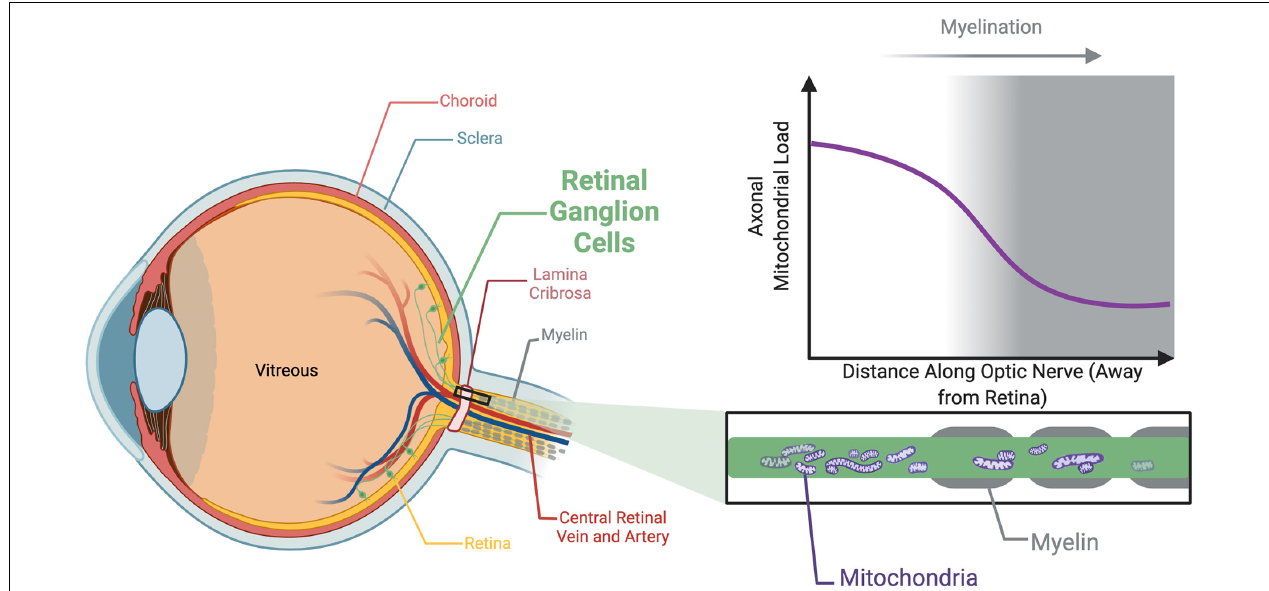
FIGURE 1 | Unmyelinated axons within the optic nerve are associated with a greater mitochondrial load. The axons of the RGCs are unmyelinated within the retina, an adaptation which likely exists to prevent myelin from impeding light reaching the photoreceptors. Myelination initiates following the lamina cribrosa, a network of collagen fibers in the optic nerve head approximately 400 µ m thick the RGC axons traverse to pass through the sclera. The unmyelinated region is associated with a higher density of mitochondria than the adjacent myelinated sections. This unique architecture of the RGCs is a possible explanation as to why the optic nerve appears so vulnerable to degeneration associated with mitochondrial